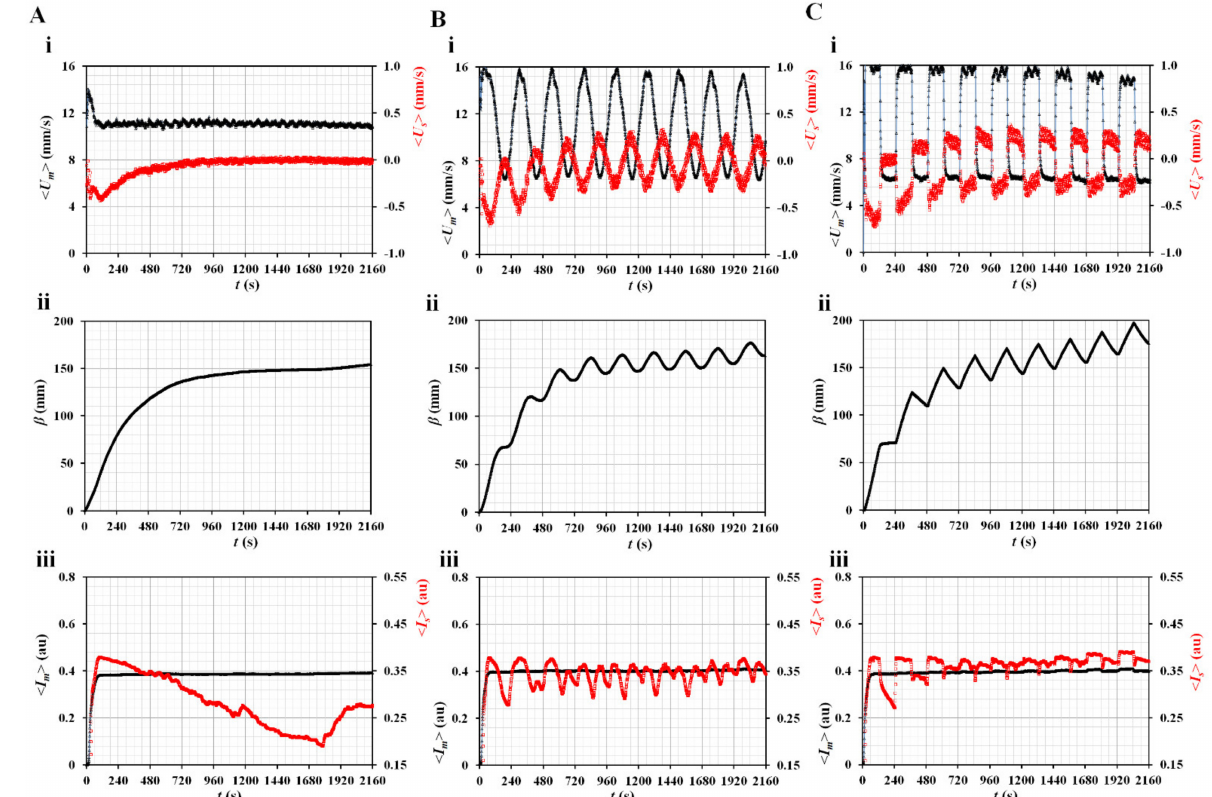
Figure 3. Contributions of a flow rate profile to variation of velocity, image intensity, and pressure in the side channel. ( A ) Temporal variations of ( i ) blood velocities (< U m >, < U s >), ( ii ) β , ( iii ) im- age intensities (< I m >, < I s >) under constant flow rate ( Q b = 1 mL/h). ( B ) Temporal variations of ( i ) blood velocities (< U m >, < U s >), ( ii ) β , ( iii ) image intensities (< I m >, < I s >) under pulsatile